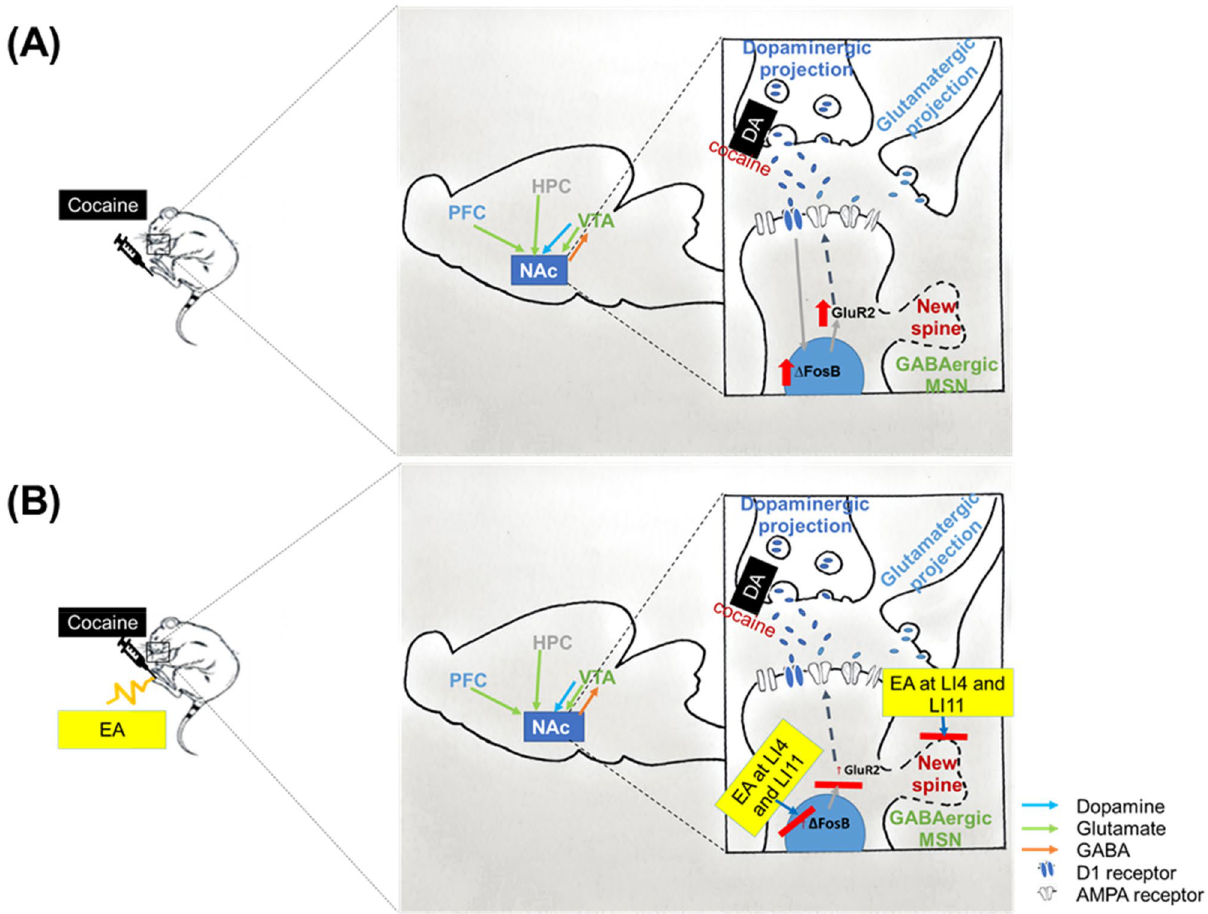
Figure 6. Schematic diagram showing synaptic events that occur after exposure to cocaine and subsequent events occurring in the NAc. ( A ) Cocaine upregulates levels of ΔFosB and GluR2 expression in the NAc. Chronic cocaine increases dendritic spine density in the NAc. ( B ) EA at LI4 and L11 reverses cocaine-induced changes in levels of ΔFosB and GluR2 expression in the NAc and also reverses the increases in dendritic spine